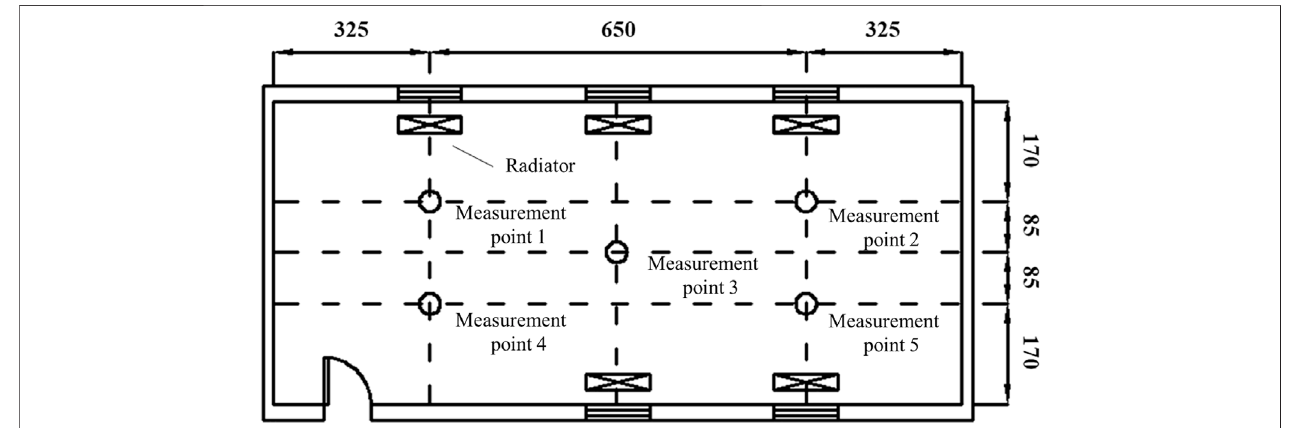
FIGURE 3 | Arrangement of radiators and measuring points (unit: